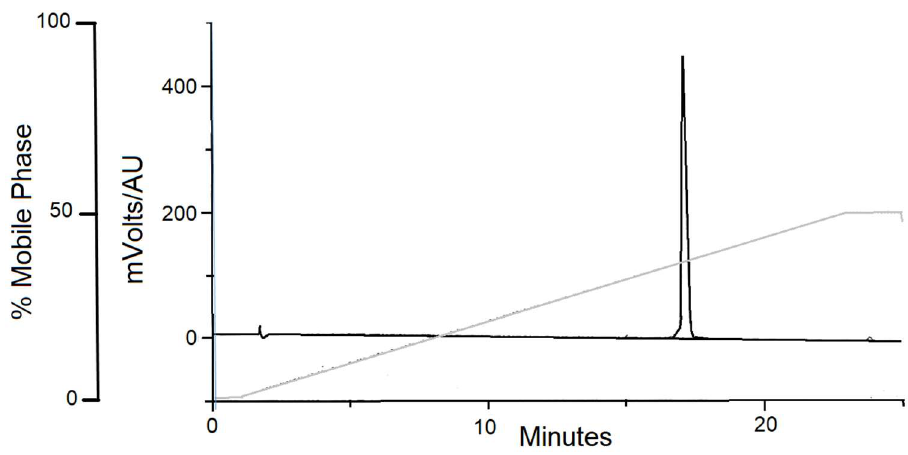
Figure 7. HPLC analysis of peptide LETI-11 sample. Column: DeltaPak C-18, 5 μm, 100 Ȧ , 3.9 × 150 mm 2 , gradient (0.1–50)% TFA in 20 min. Detector UV 220 nm.